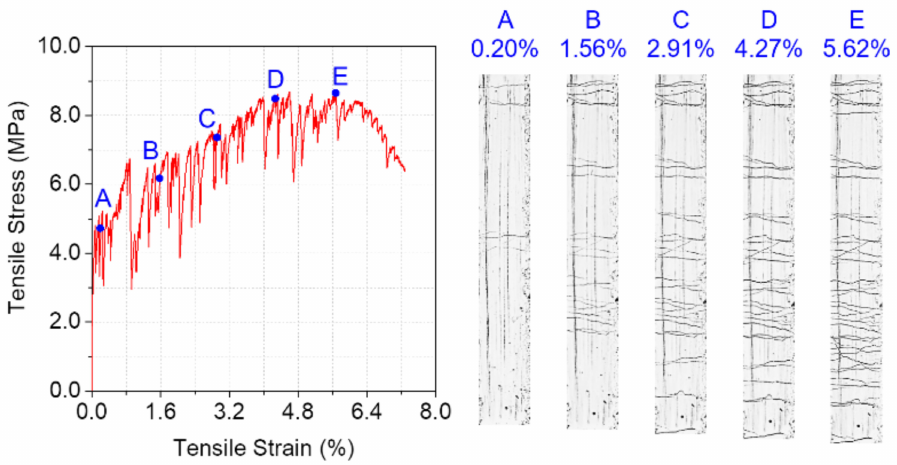
Figure 7. Crack patterns of strain-hardening UHPC with PE fibers. (Reproduced with permission from [47]). Table 4. Crack widths and distributions of strain-hardening UHPC with PE fibers. (Reproduced with permission from [47]). Number of Cracks Weibull Distribution Strain 0–15 (%) µ